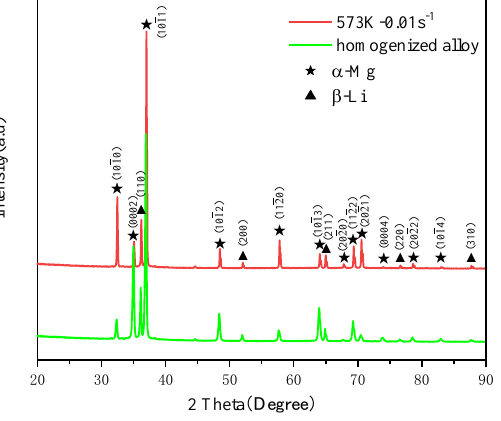
Figure 1. XRD patterns of homogenized alloy and the compressed specimen (573 K-0.01 s − 1 ).